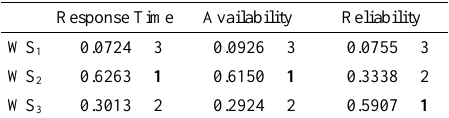
Table 5. Eigenvectors and rankings for Case 1